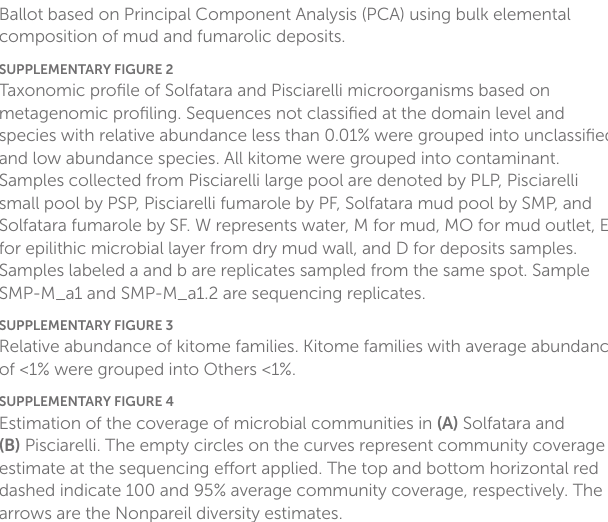
SUPPLEMENTARY FIGURE 1 Ballot based on Principal Component Analysis (PCA) using bulk elemental composition of mud and fumarolic deposits. SUPPLEMENTARY FIGURE 2 Taxonomic profile of Solfatara and Pisciarelli microorganisms based on metagenomic profiling. Sequences not classified at the domain level and species with relative abundance less than 0.01% were grouped into unclassified and low abundance species. All kitome were grouped into contaminant. Samples collected from Pisciarelli large pool are denoted by PLP, Pisciarelli small pool by PSP, Pisciarelli fumarole by PF, Solfatara mud pool by SMP, and Solfatara fumarole by SF. W represents water, M for mud, MO for mud outlet, E for epilithic microbial layer from dry mud wall, and D for deposits samples. Samples labeled a and b are replicates sampled from the same spot. Sample SMP-M_a1 and SMP-M_a1.2 are sequencing replicates. SUPPLEMENTARY FIGURE 3 Relative abundance of kitome families. Kitome families with average abundance of <1% were grouped into Others <1%. SUPPLEMENTARY FIGURE 4 Estimation of the coverage of microbial communities in (A) Solfatara and (B) Pisciarelli. The empty circles on the curves represent community coverage estimate at the sequencing effort applied. The top and bottom horizontal red dashed indicate 100 and 95% average community coverage, respectively. The arrows are the Nonpareil diversity